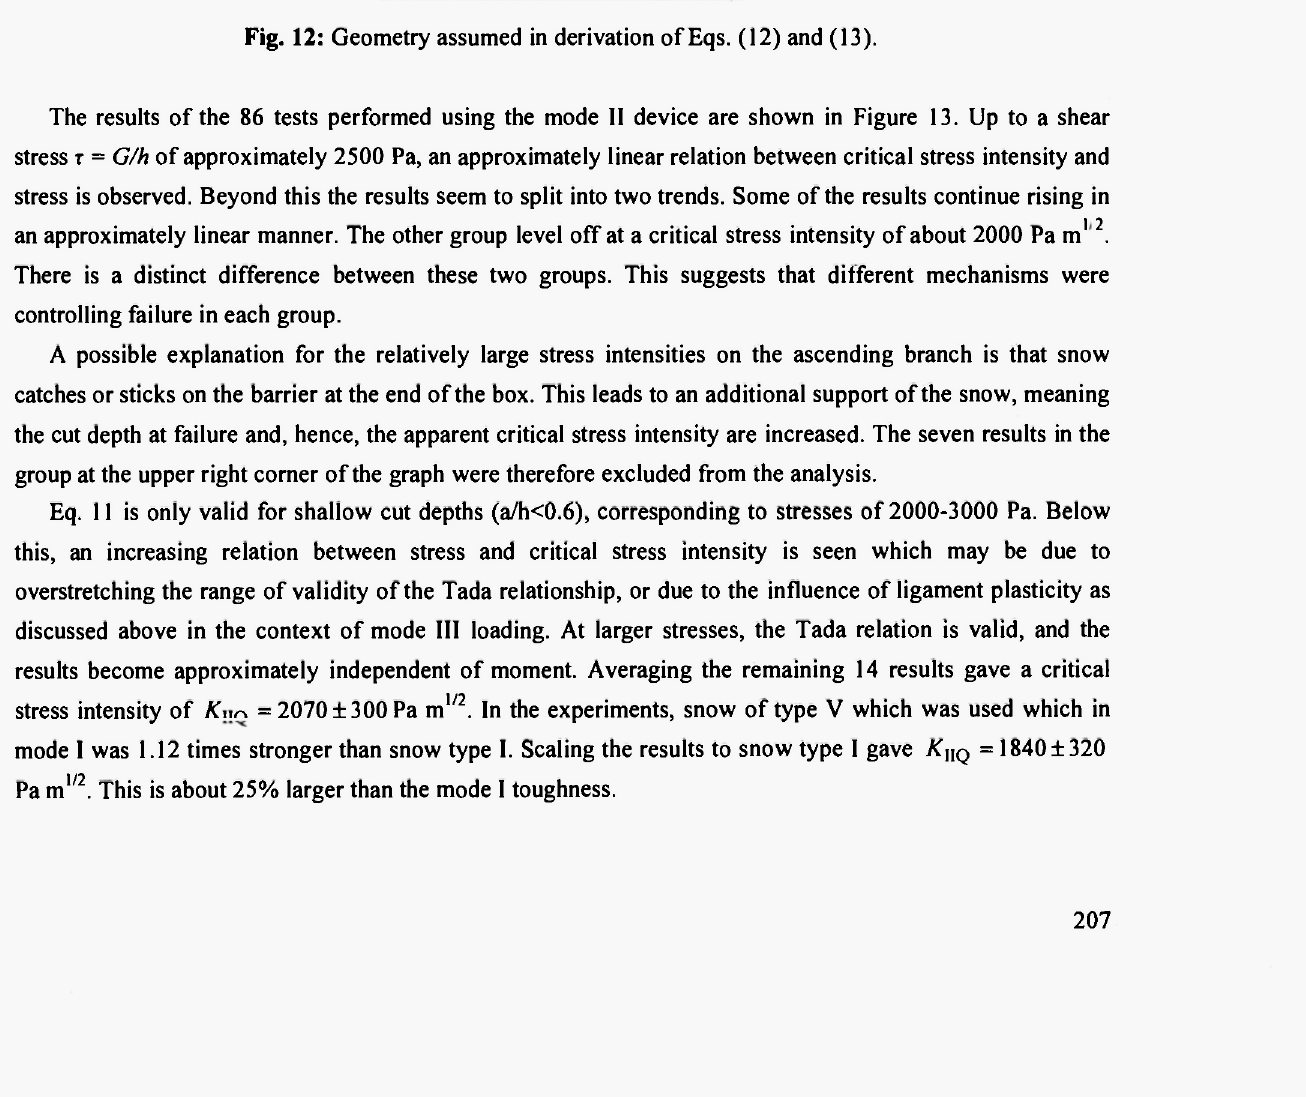
Fig. 12: Geometry assumed in derivation of Eqs. (12) and